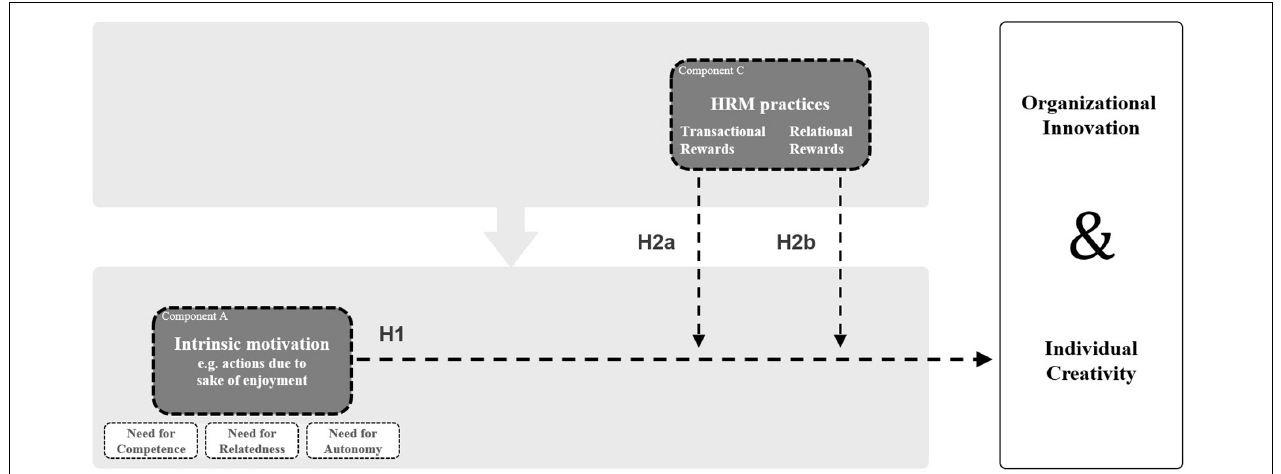
FIGURE 3 | Hypothesized interaction of intrinsic motivation and rewards on creativity and innovation